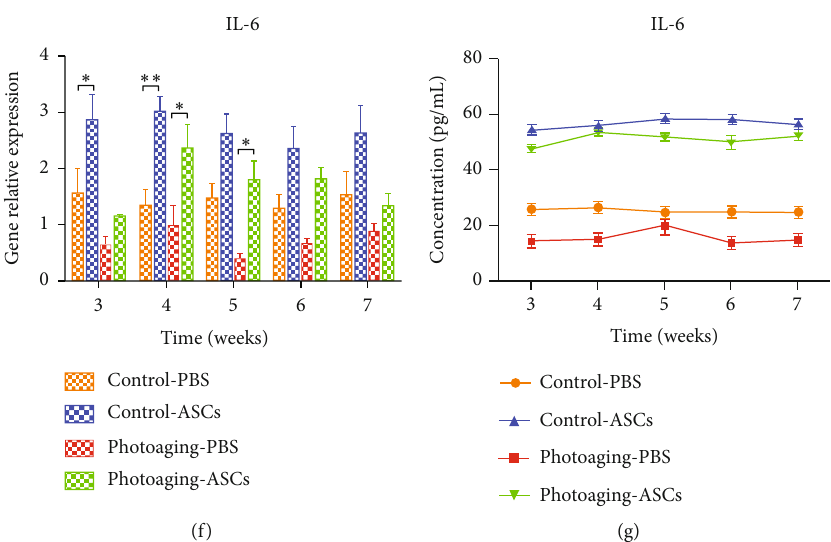
Figure 7: ROS levels and the expression of Nrf-2 and IL-6 in mouse skin. (a, b) The percentage of ROS-positive cells in mouse skin. (c, f) RT- PCR results showing gene expression in mouse skin. (d, g) The level of Nrf-2/IL-6 in skin tissue homogenates. (e) Immunohistochemical labeling of Nrf-2 at 7